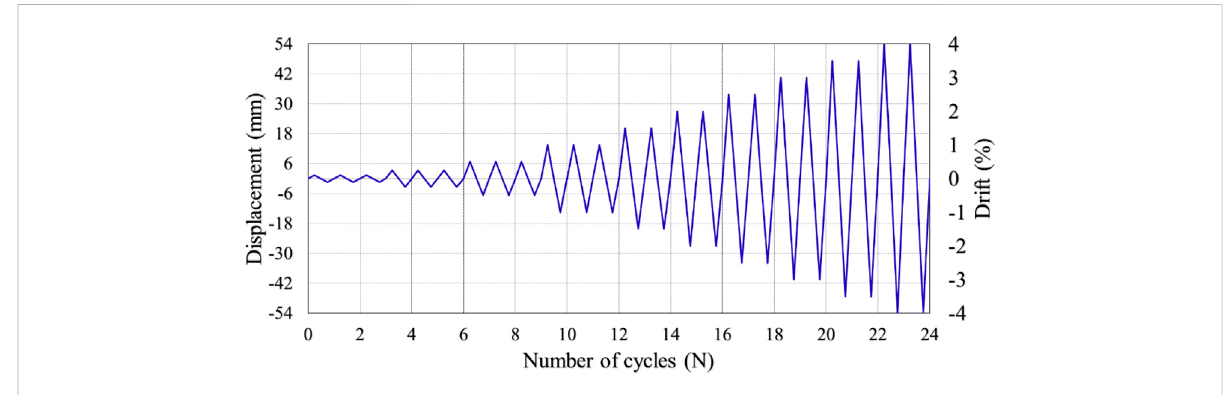
FIGURE 5 Applied loading